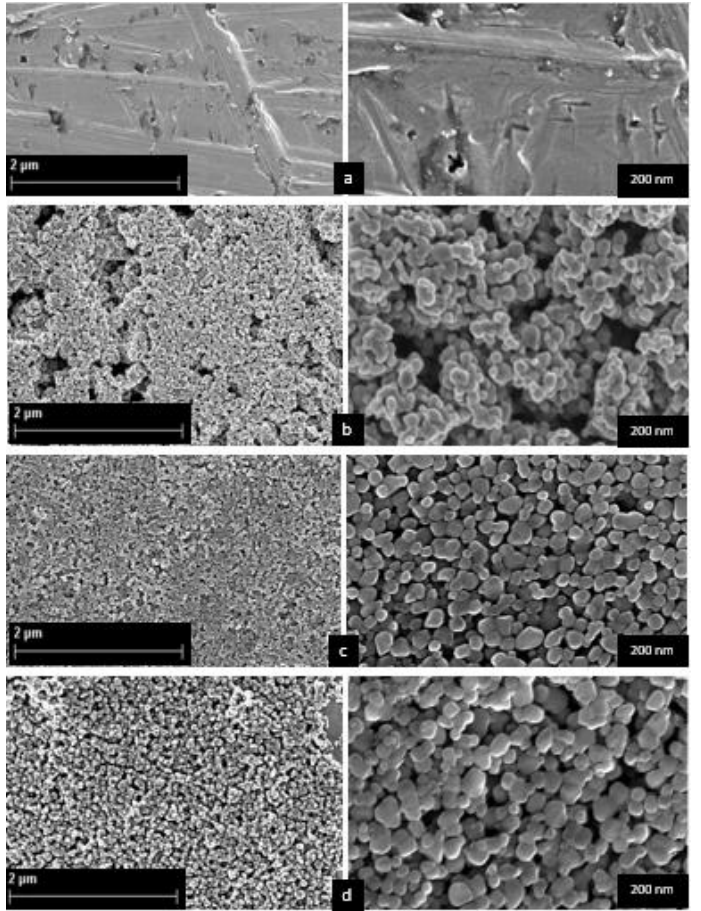
Figure 6. FESEM micrographs of the surface coated aluminum plate ( a ) uncoated; coated with TiO 2 at ( b ) 0.1 M, ( c ) 0.5 M, and ( d ) 1.0